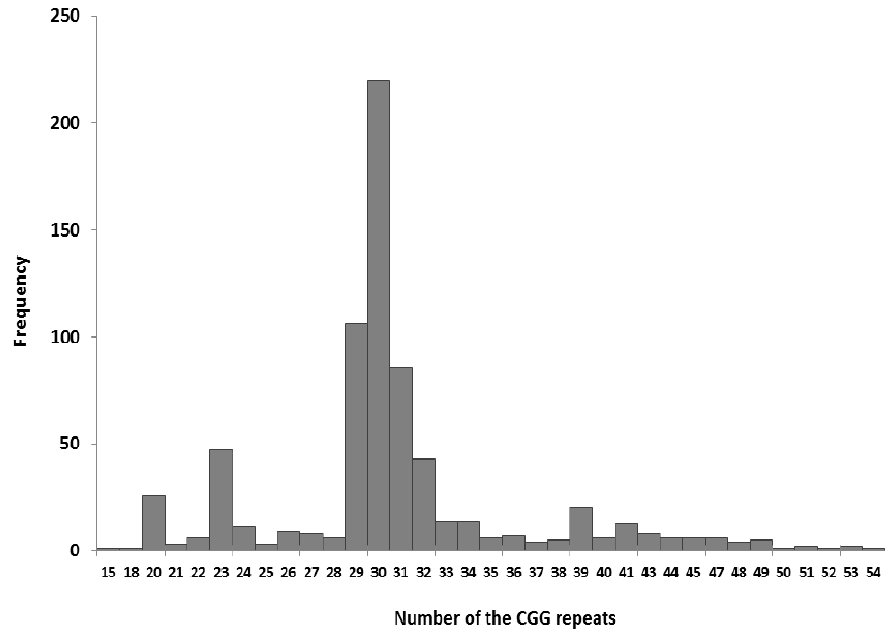
Figure 2. The size distribution of CGG alleles in FMR1 gene. Histogram displays the frequency of alleles with different number of CGG repeats in normal range alleles, including intermediate alleles.